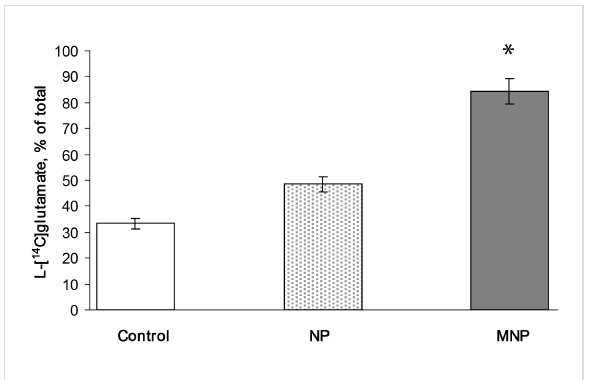
Figure 7: Movement of L-[ 14 C]glutamate-containing synaptosomes to the magnet. Control (transparent column): synaptosomes in the absence of nanoparticles, NP (dotted column): synaptosomes in the presence of uncoated γ -Fe 2 O 3 nanoparticles, MNP (grey column): synaptosomes in the presence of D-mannose-coated γ -Fe 2 O 3 nanoparticles. The synaptosomes were pre-loaded with L-[ 14 C]gluta- mate (1 nmol/mg of protein, 238 mCi/mmol), then uncoated or D-mannose-coated nanoparticles were added to synaptosomes and the amount of L-[ 14 C]glutamate the aliquots of synaptosomal suspen- sion in the vicinity of application of magnetic field was determined after rapid sedimentation by using a microcentrifuge (20 s at 10,000 g ). Total synaptosomal L-[ 14 C]glutamate content was equal to 200,000 ± 15,000 cpm/mg protein. Data are means ± SEM of five independent experiments, each performed in triplicate. * Р ≤ 0.05, Student's t